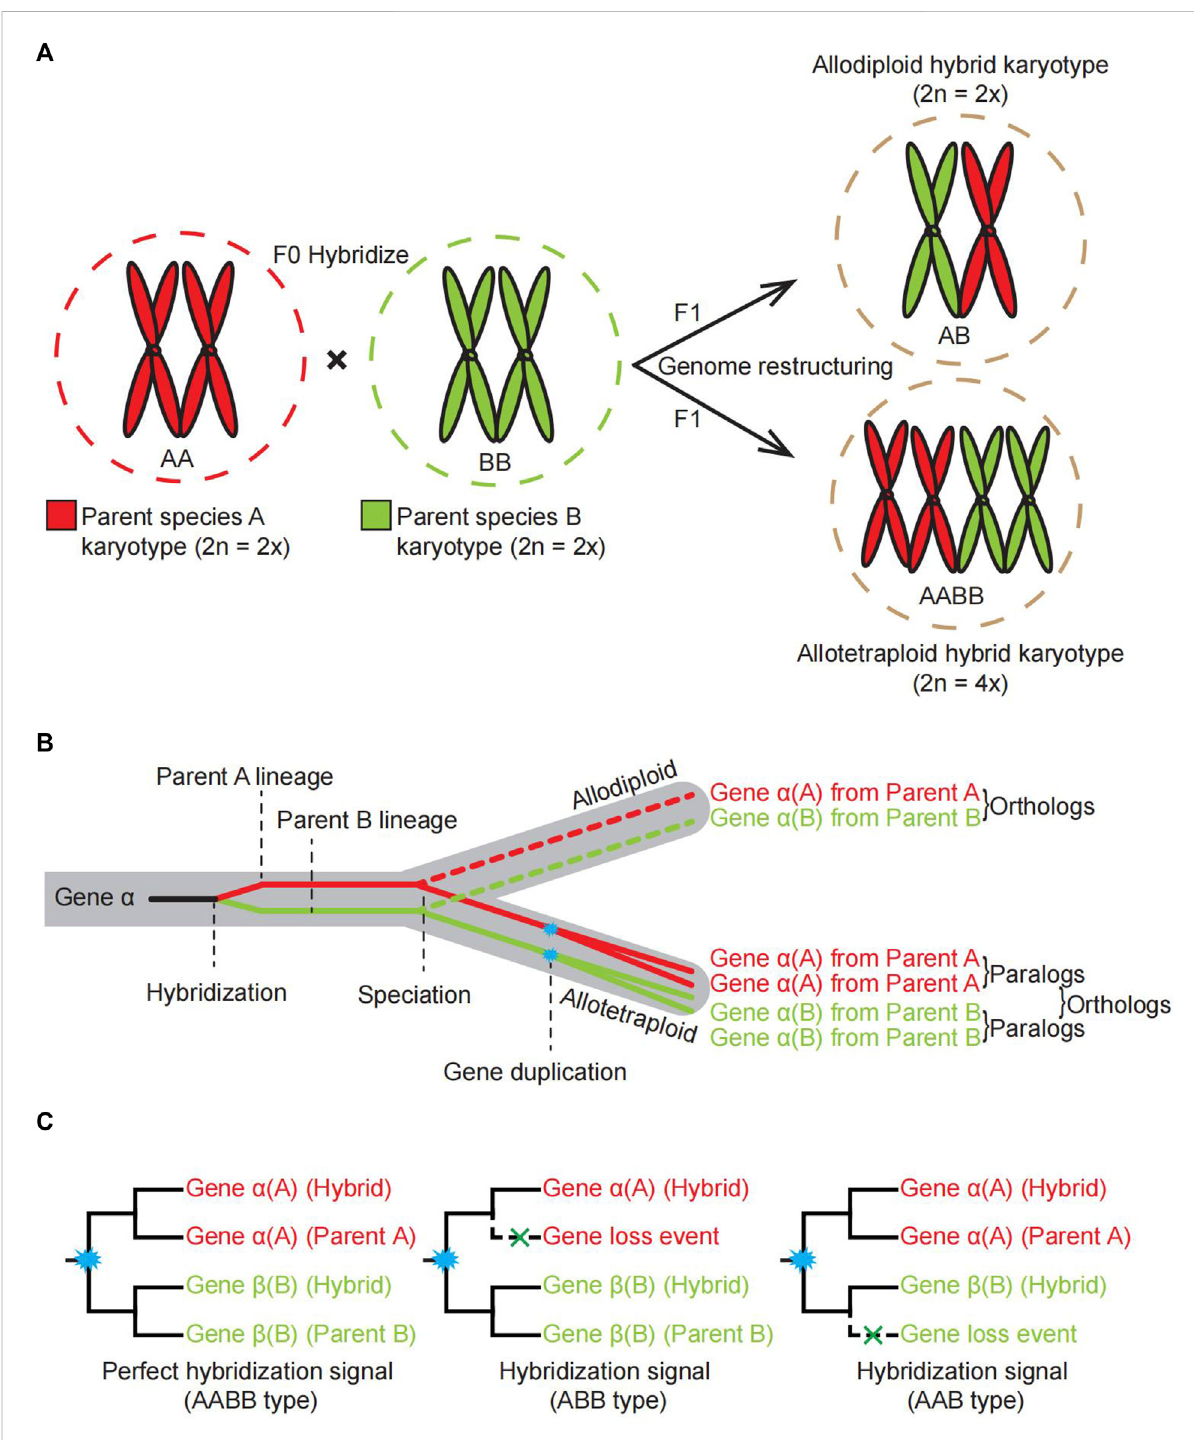
FIGURE 1 Schematic illustrating the processes of allopolyploidy events, dynamics of karyotype changes and different types of gene family trees consideredashybridizationsignals. (A) .Thedynamickaryotypechangeforoffspringofallopolyploidsbycrossing twodiploidparents. (B) .Schematic diagram showing the transfer of genes from parental species to offspring through hybridization, as exempli fi ed by gene alpha. (C) . A simpli fi ed three different gene family tree topologies as signals to support a hybridization event. Cyan asterisks in the node indicate a gene duplication